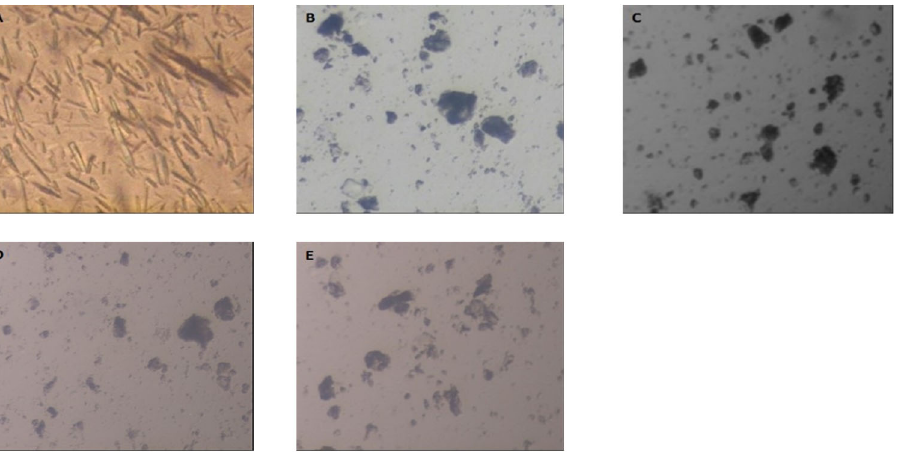
Figure 2. Optical microscope photographs of ( A ) plain Tel, ( B ) F8, ( C ) F9, ( D ) F14, and ( E ) F15.